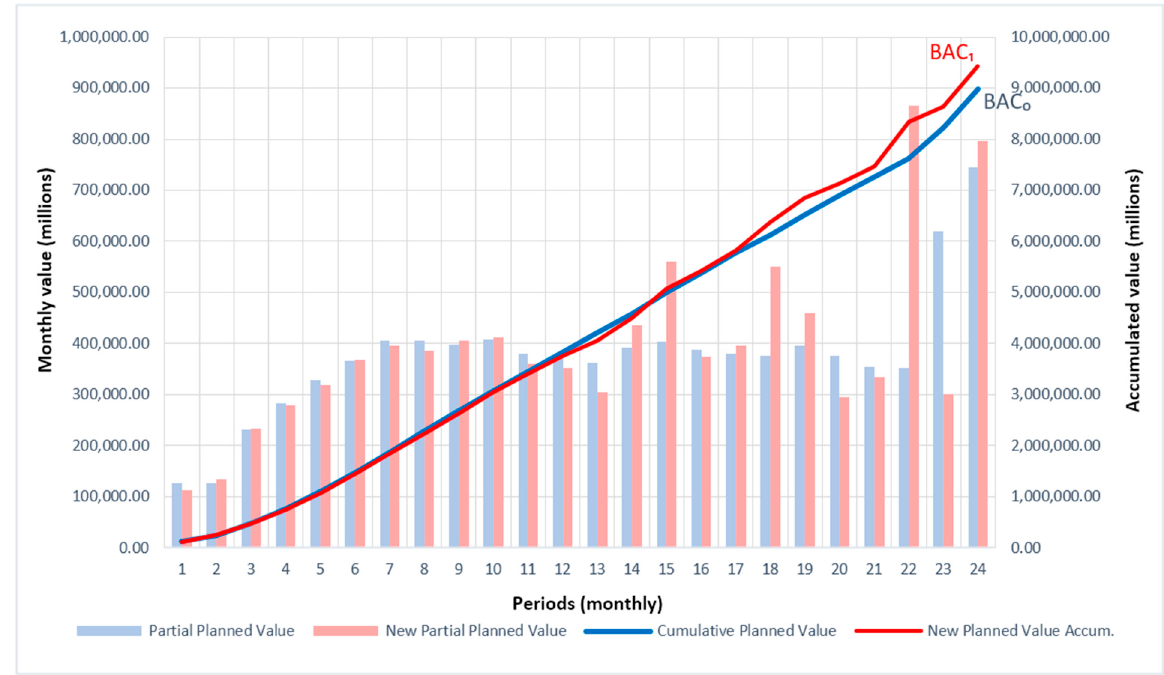
Buildings 2022 , 12 , x FOR PEER REVIEW Figure 5. Original and final planned S-curve: Project 002 (source: Proaño-Narváez). Figure 5. Original and final planned S-curve: Project 002 (source: Proaño-Narv á ez).